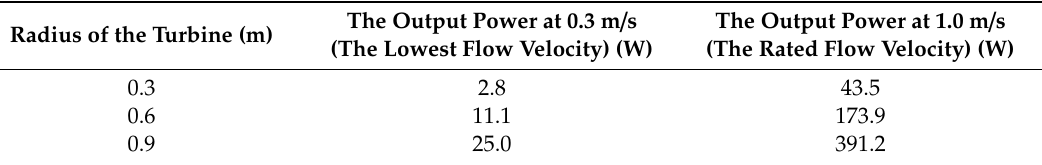
Table 4. The calculated power output with a larger radius turbine for the proposed LOCH. Radius of the Turbine